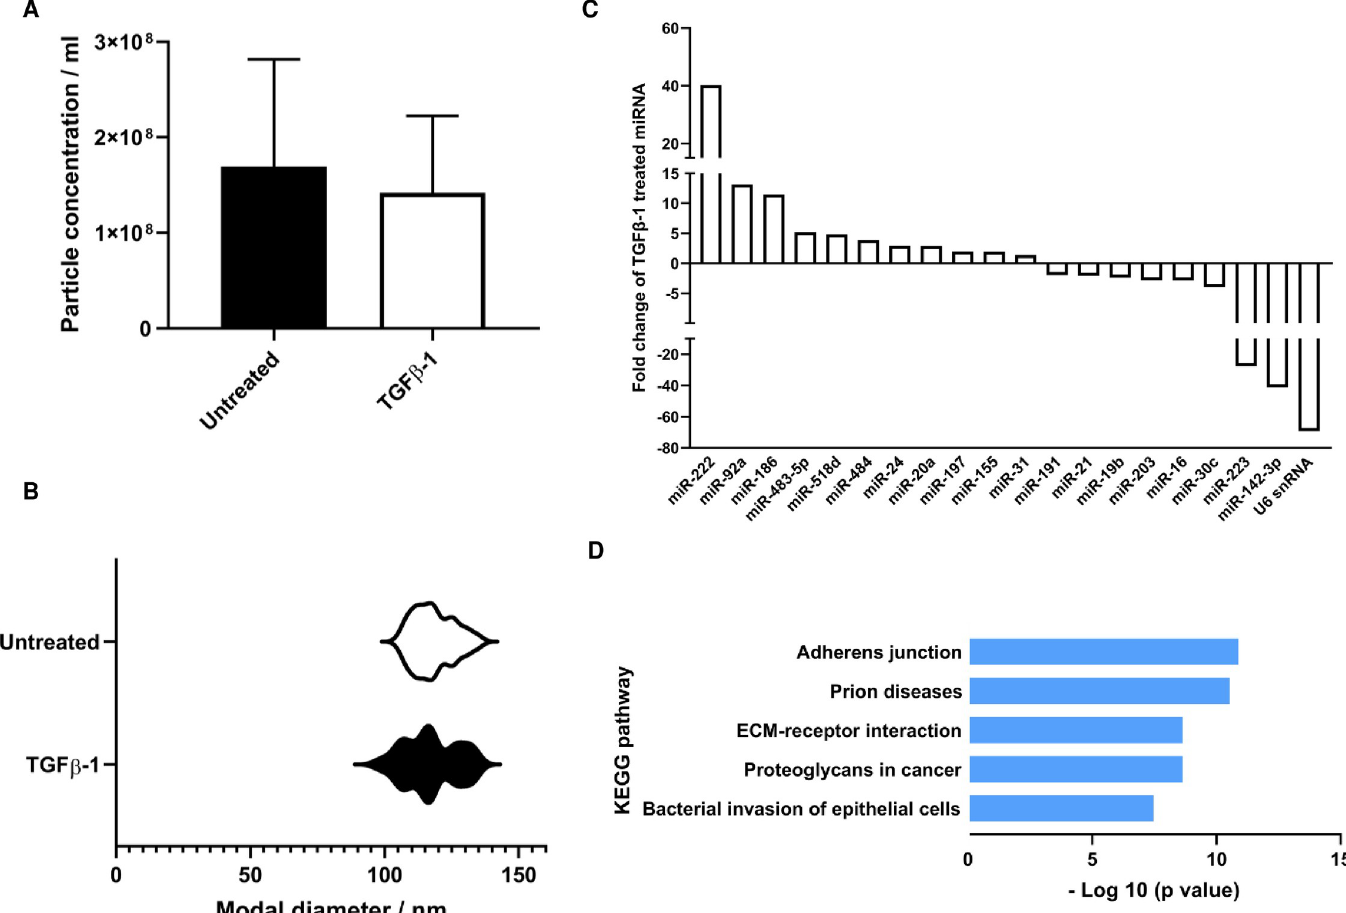
Fig 3. Characterisation of eCAF-derived EV and their miRNA cargo. EV were isolated from the conditioned media of fibroblasts treated with TGF- β 1 (5 ng/ml) or their untreated counterparts using size-exclusion chromatography. The concentration (A) and size (B) of the isolated particles was analysed using nanoparticle tracking (Zetaview, Particle Metrix). Total RNA was extracted from isolated EV and their miRNA cargo was assessed using tiling low- density array quantitative PCR (C). KEGG pathway analysis on the three most elevated miRNA (miR-222, miR-92a and miR-186 combined) was conducted using DIANA (D) [14].